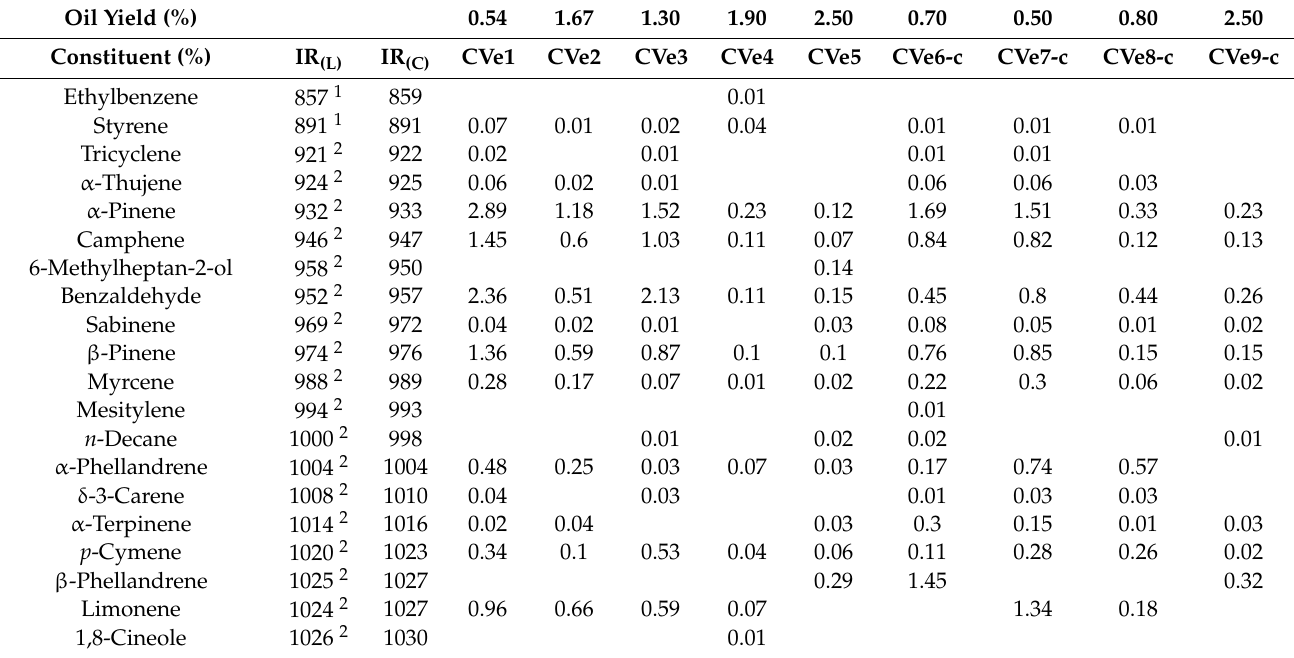
Table 1. Volatile compositions of Cinnamomum verum leaf essential